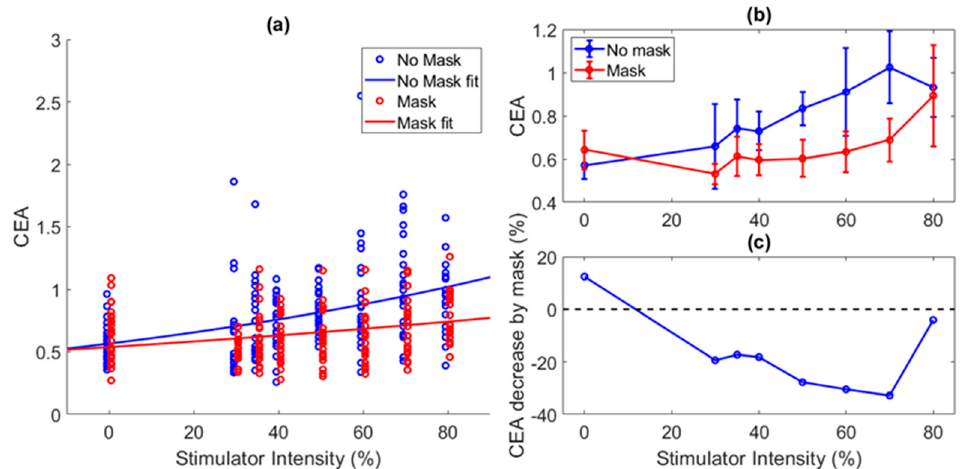
Figure 5. ( a ) Scatterplot of CEA values per SI and exponential line fit for the cases of no mask (blue circles and lines) and mask (red circles and lines), ( b ) average CEA as a function of SI for the cases of no mask (blue) and mask (red), ( c ) percentage decrease in CEA when the auditory function is used, as a function of SI.